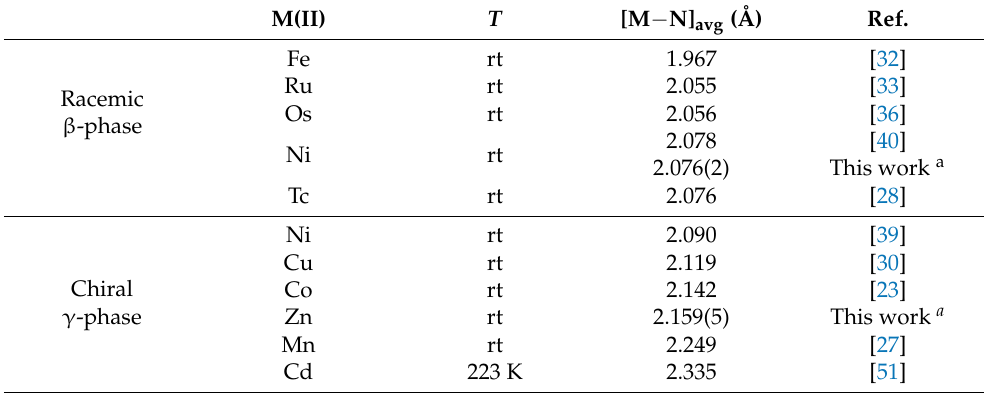
Table 4. [M(bpy) 3 ](PF 6 ) 2 compounds organized by average M − N distance.